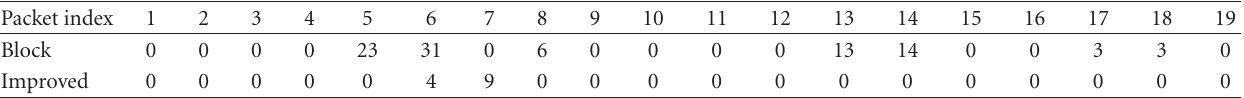
Table 3: Performance of the experimental results between the improved and block-based Doppler shift techniques for N c = 512. Packet index Improved